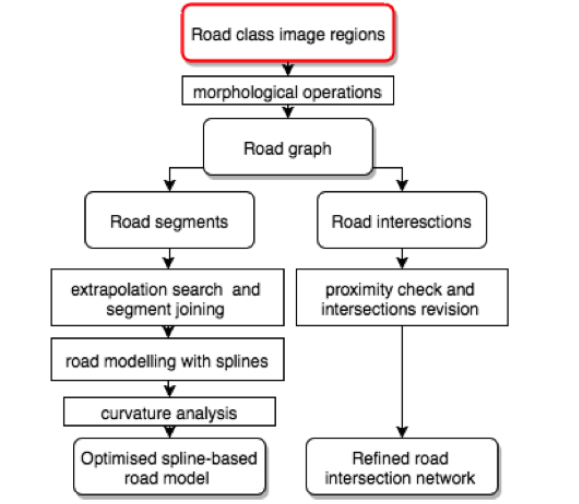
Figure 4: Flowchart of road network generation from road com- ponents detected in the